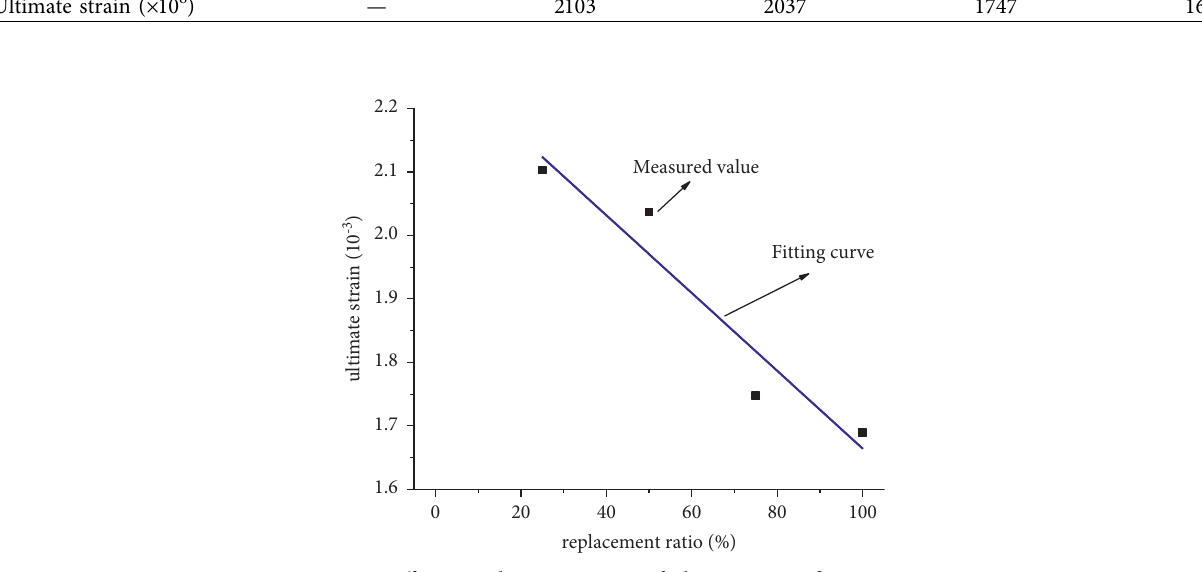
Figure 9: Different replacement ratios of ultimate strain fitting